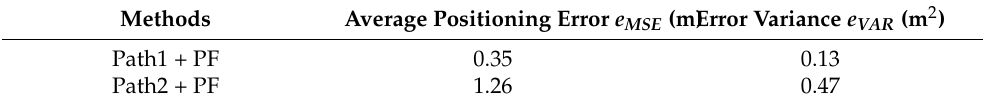
Table 6. The localization effects of using MSDO method and particle filter (MSDO-PF).